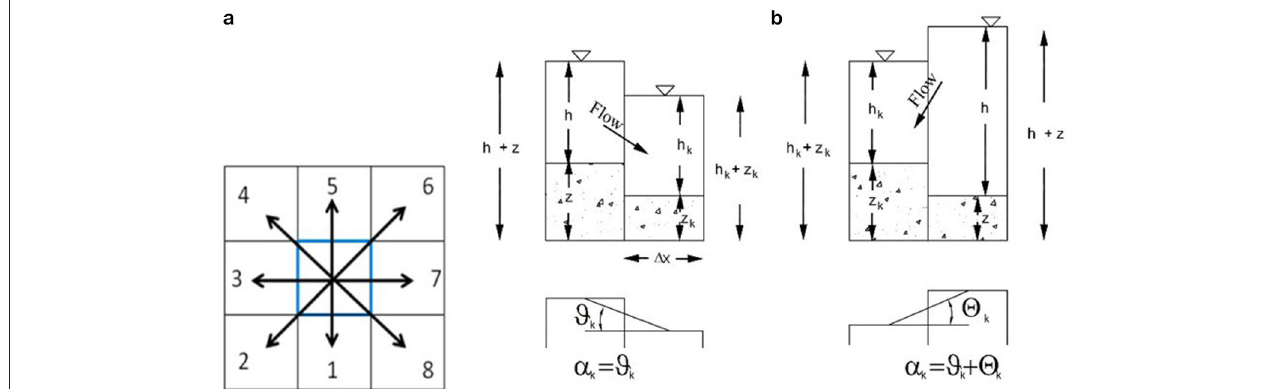
FIGURE 7 | The eight possible flow directions (a) and the two possible flow conditions of the routing model (b) ; partial redrawing of the Figures 1 and 2 of Gregoretti et al.